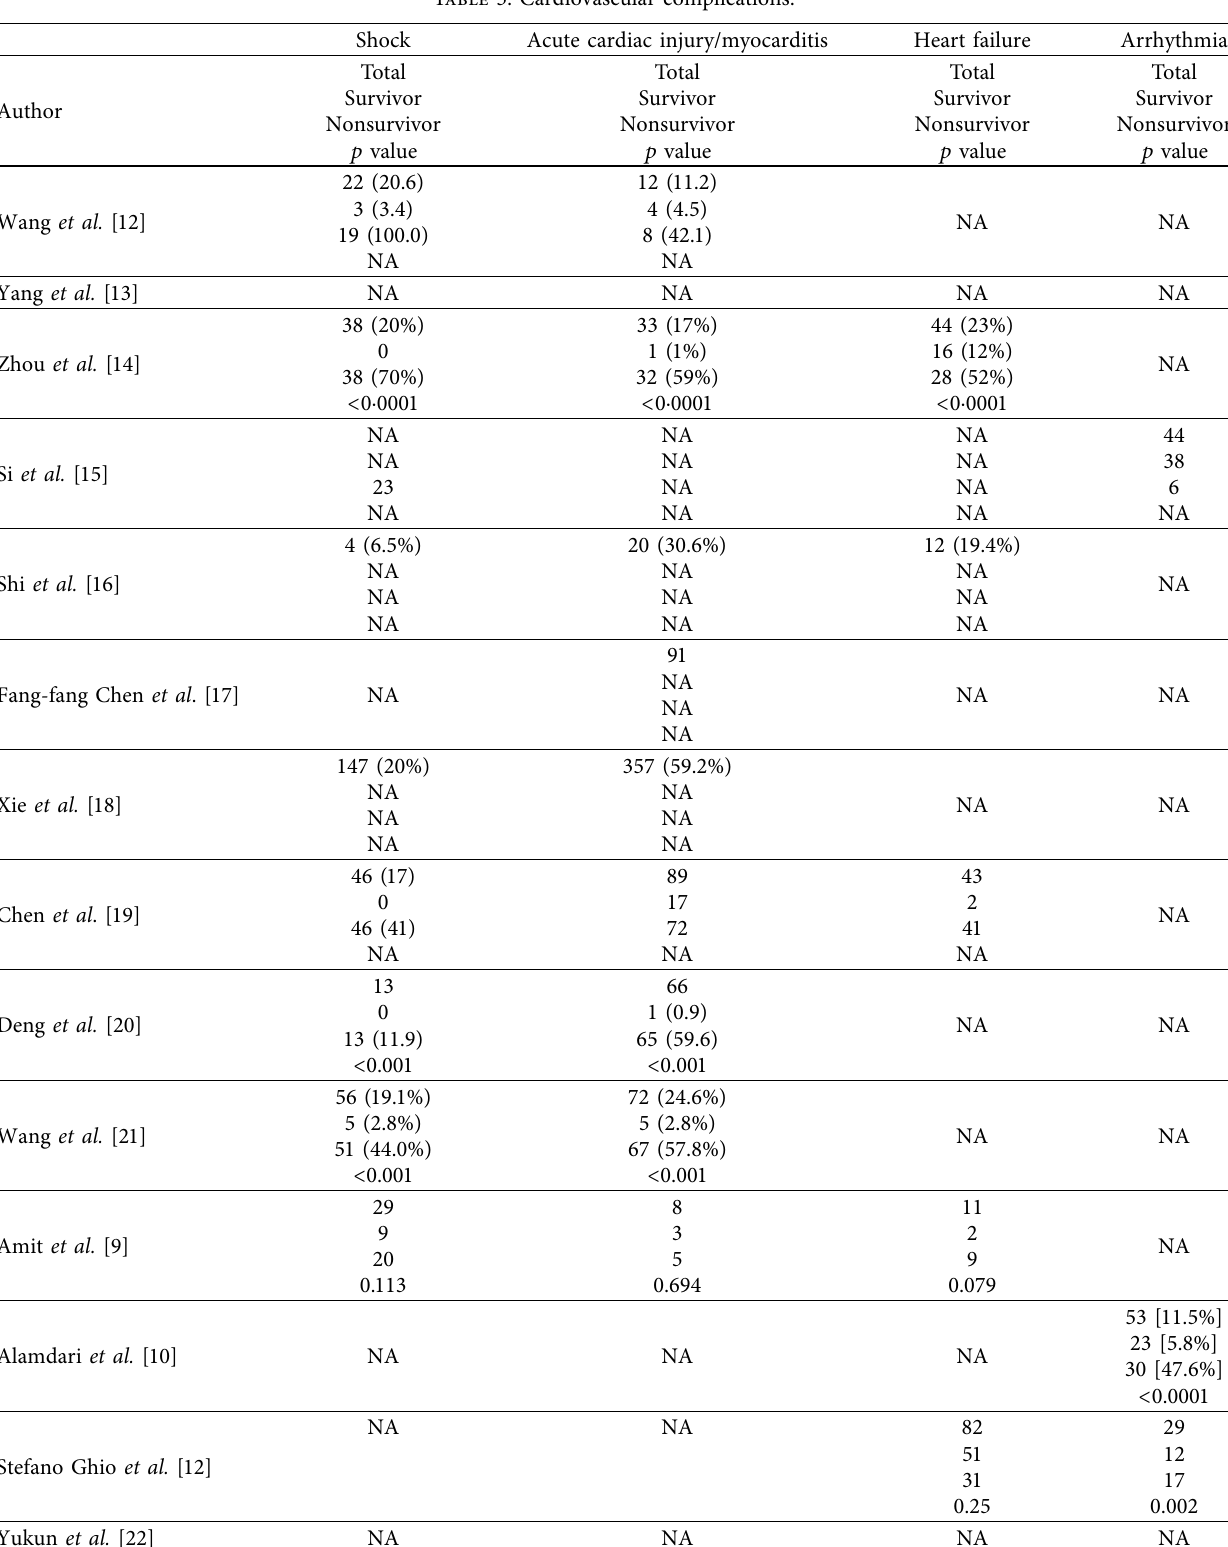
Table 5: Cardiovascular